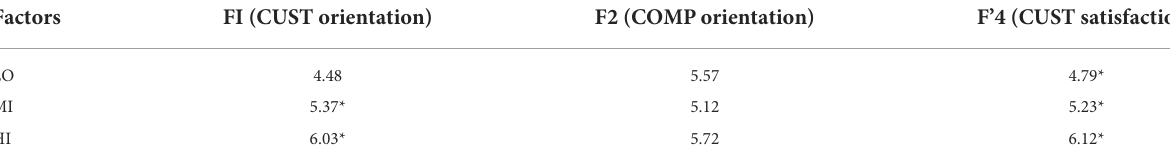
TABLE 7 Analysis of variance (ANOVA), the average of the strategic marketing factors.